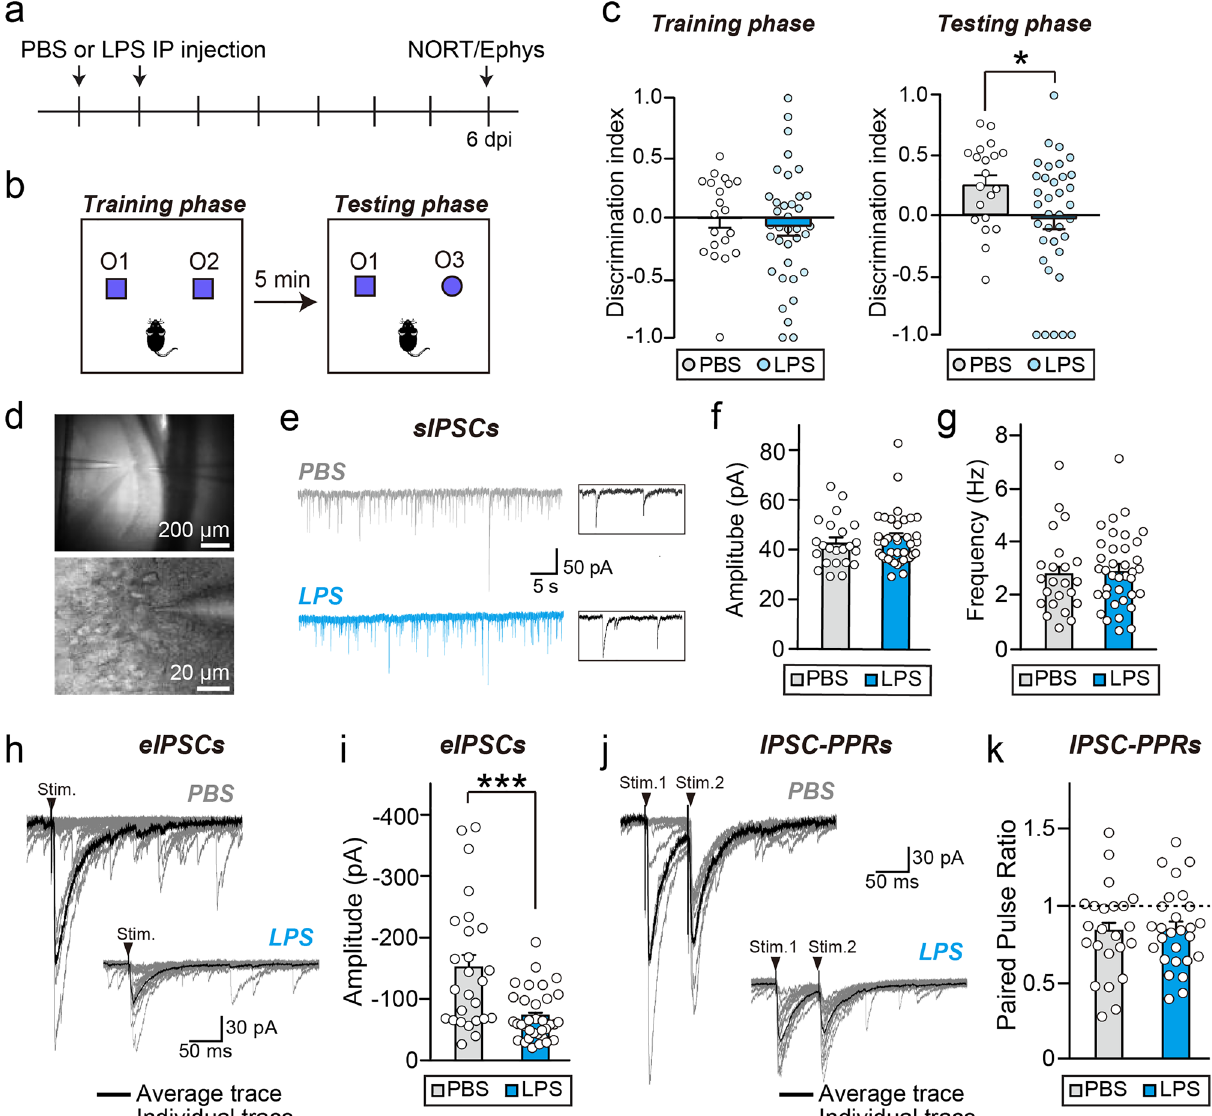
Figure 7. Impaired short-term memory induced by neuroinflammation is correlated with GABAergic synaptic transmission deficits. ( a ) Schematic illustration of the experimental procedure for LPS administration, novel object recognition test (NORT), followed by electrophysiological recordings (ephys) on hippocampal neurons ex vivo in mice. ( b ) Design of experiments measuring novel object-recognition memories. Two identical objects (O1 and O2) were used for the training phase, and one familiar object (O1) and one novel object (O3) were used for the testing phase. ( c ) Discrimination index in the training phase (left) or testing phase (right) was plotted. Data are presented as means ± SEMs (training phase: PBS, 0 ± 0.08; LPS, − 0.01 ± 0.08; P = 0.5358; testing phase: PBS, 0.25 ± 0.08; LPS, − 0.03 ± 0.08; * P < 0.05; PBS, N = 20; LPS, N = 36; Mann–Whitney U -test). ( d ) Bright field images showing a whole-cell recording from a hippocampal CA1 pyramidal neuron. ( e ) Representative spontaneous IPSC traces (left) and enlarged trace (right) of hippocampal CA1 pyramidal neurons treated with PBS versus LPS. ( f , g ) The amplitudes ( f ) and frequencies ( g ) of sIPSCs recorded from hippocampal slices of mice treated with LPS or PBS. Data are presented as means ± SEMs (amplitude: PBS, 43.74 ± 1.87; LPS, 45.48 ± 1.66; P = 0.5360; frequency: PBS, 2.80 ± 0.31; LPS, 2.96 ± 0.22; P = 0.4873; PBS, n = 23 from 18 mice; LPS, n = 37 from 14 mice; Mann–Whitney U -test). ( h ) Representative evoked IPSC (eIPSC) traces of hippocampal CA1 pyramidal neurons. The individual trace of each electrical stimulation is shown in gray and the average traces obtained from 20 iterations are shown in black. ( i ) The amplitudes of eIPSCs recorded from hippocampal slices was significantly smaller for mice treated with LPS compared to those treated with PBS (amplitude: PBS, − 151.49 ± 20.30; LPS, − 72.13 ± 7.03; *** P = 0.0002; PBS, n = 26 from 18 mice; LPS, n = 34 from 14 mice; Mann– Whitney U -test). ( j , k ) There was no difference between PBS- and LPS-treated groups in the paired-pulse ratio (PPR) obtained with various stimulus intervals (PPR: PBS, 0.83 ± 0.06; LPS, 0.85 ± 0.05; P = 0.9692; PBS, n = 23 from 18 mice; LPS n = 27 from 14 mice; Mann–Whitney U